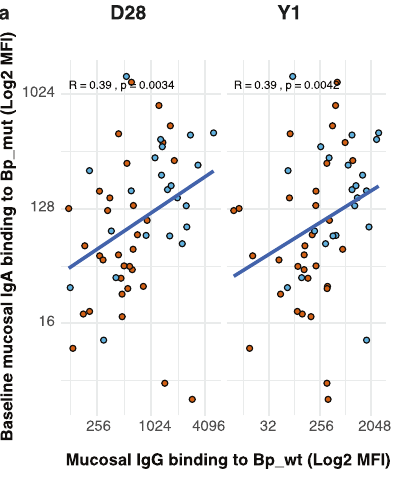
Fig. 7 | Correlation between baseline Bp_mut antibody deposition and the antibody levels after aP booster vaccination in aP-primed individuals. a Spearman correlation between mucosal IgA binding to Bp_mut and mucosal IgG binding to Bp_wt at day 28 and one year (log2-transformed mean fl uorenscence